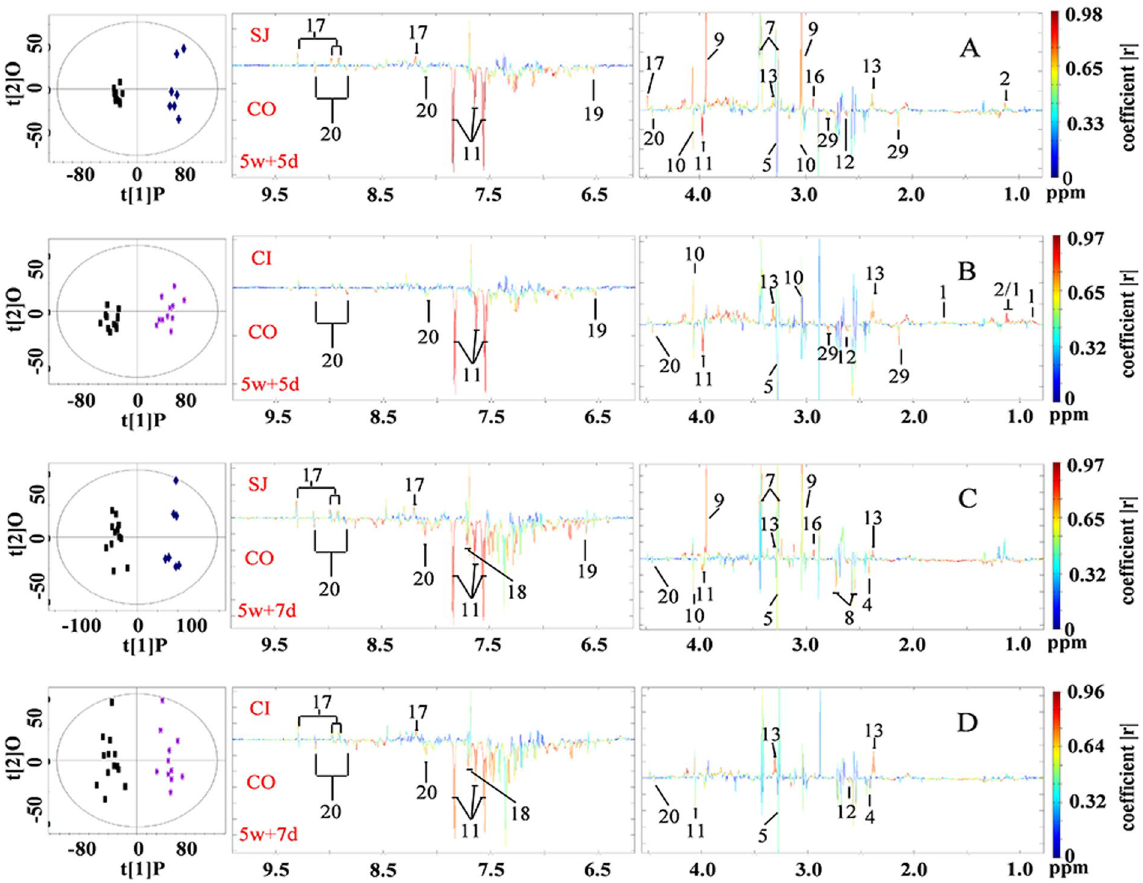
Figure 3. Scores plots and corresponding color-coded coefficient plots. These plots derived from O-PLS-DA of 1 H NMR spectral data obtained from urine of uninfected control mice (CO), S. japonicum infected mice (SJ) and mice coinfected with S. japonicum and S. typhimurium (CI). Signals upwards indicate increase in the levels of metabolites compared with the control; signals downwards denote a decrease. 5w + 5d, time point, five days after coinfection; 5w + 7d, time point, seven days after coinfection. Keys: 1, 2-keto-3-methy-valerate; 2, 2-keto- isovalerate; 4, succinate; 5, trimethylamine- N -oxide (TMAO); 7, taurine; 8, citrate; 9, creatine; 10, creatinine; 11, hippurate; 12, 2-keto-isocaproate; 13, 3-ureidopropionate (3-UP); 16, dimethylglycine (DMG); 17, N - methylnicotinamide; 18, indoxyl sulfate; 19, fumarate; 20, trigonelline; 29, N -acetylglutamic